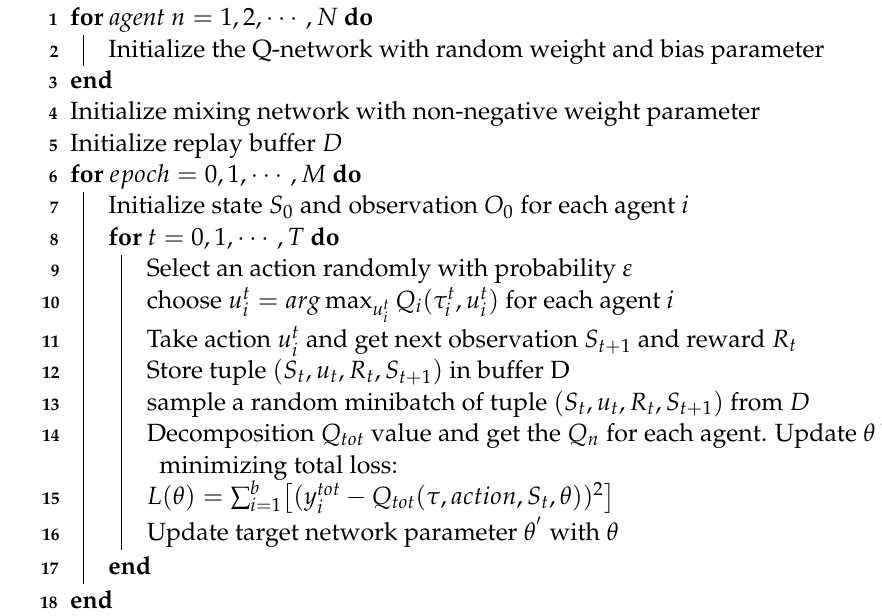
Algorithm 1: Multi-Agent Deep Reinforcement Learning Algorithm with Credit